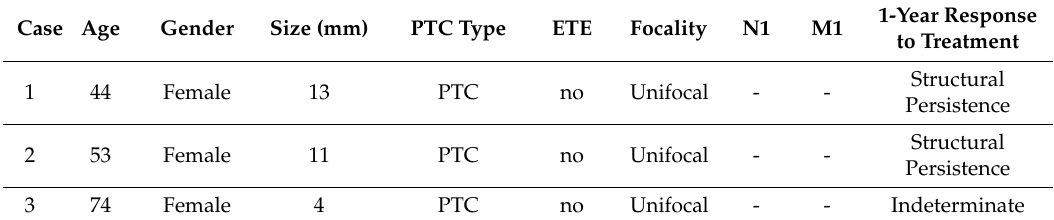
Table 3. Baseline characteristics of papillary thyroid cancer (PTC) patients with incomplete response to initial treatment at 1-year reassessment.